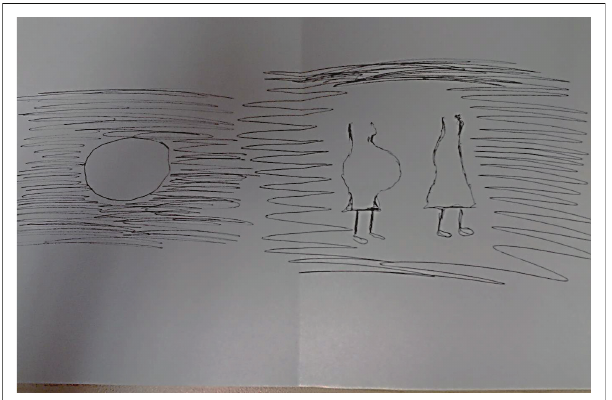
FIGURE 2: Drawing of Dream 4, the stillborn dream.